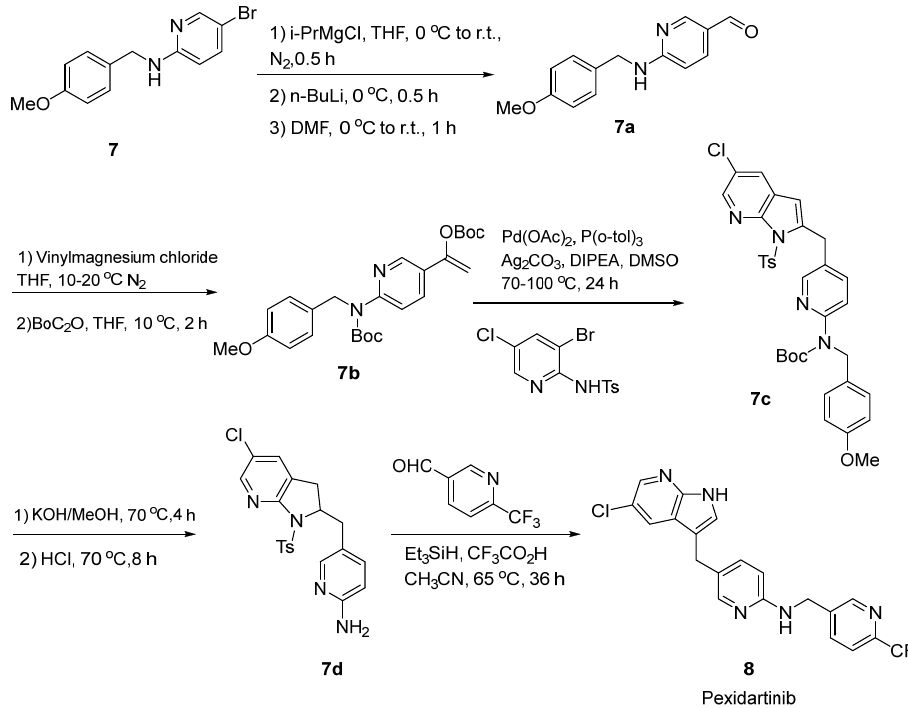
Figure 4. Synthesis and structure of pexidartinib.